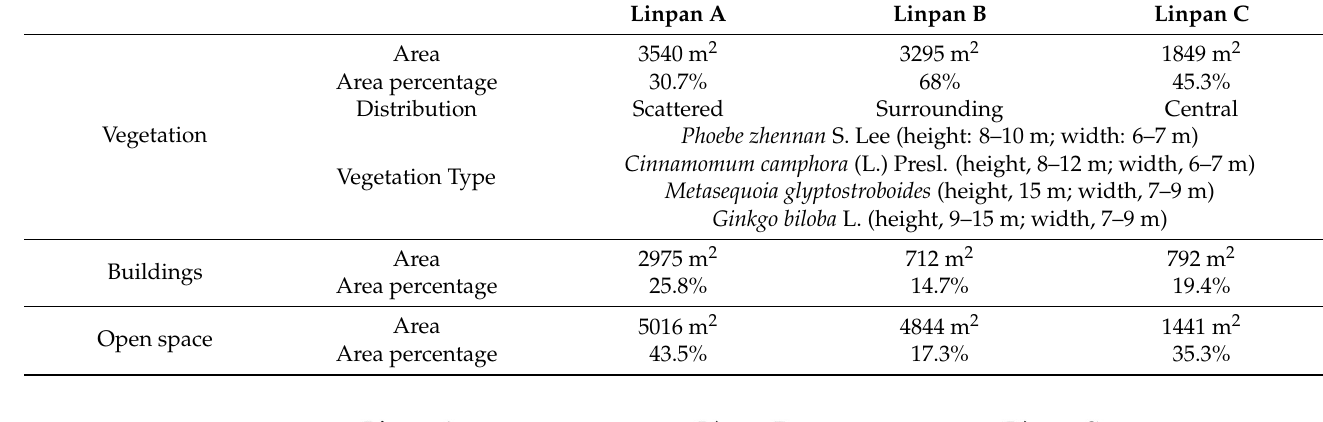
Table 2. The composition of Linpan A, B, and C.